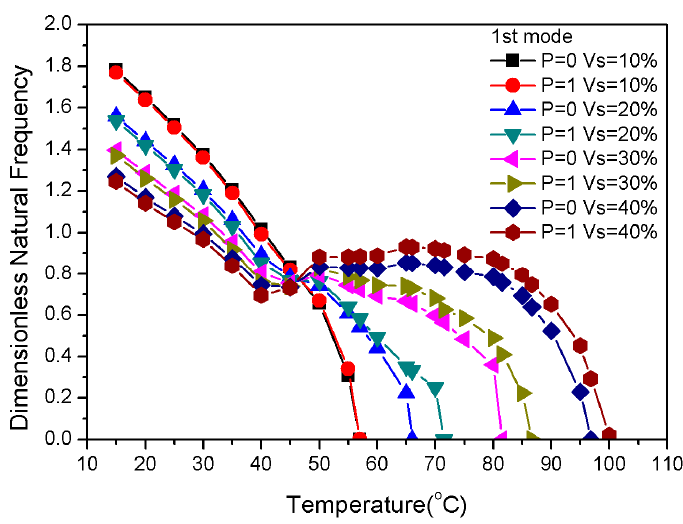
Figure 8. The total percentage of the SMA in each ply.